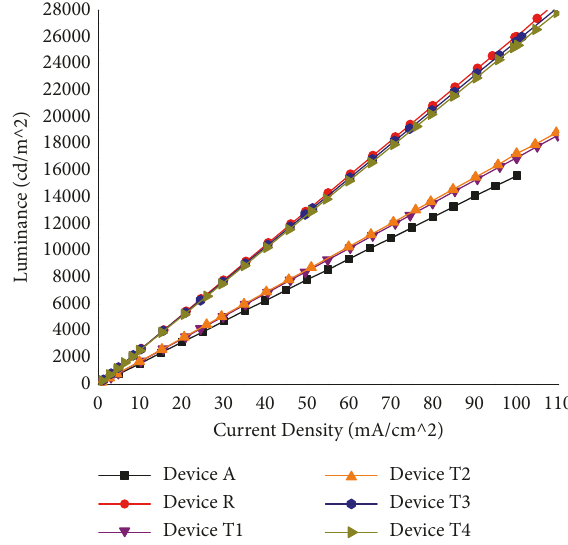
Figure 8: Luminance plot of various